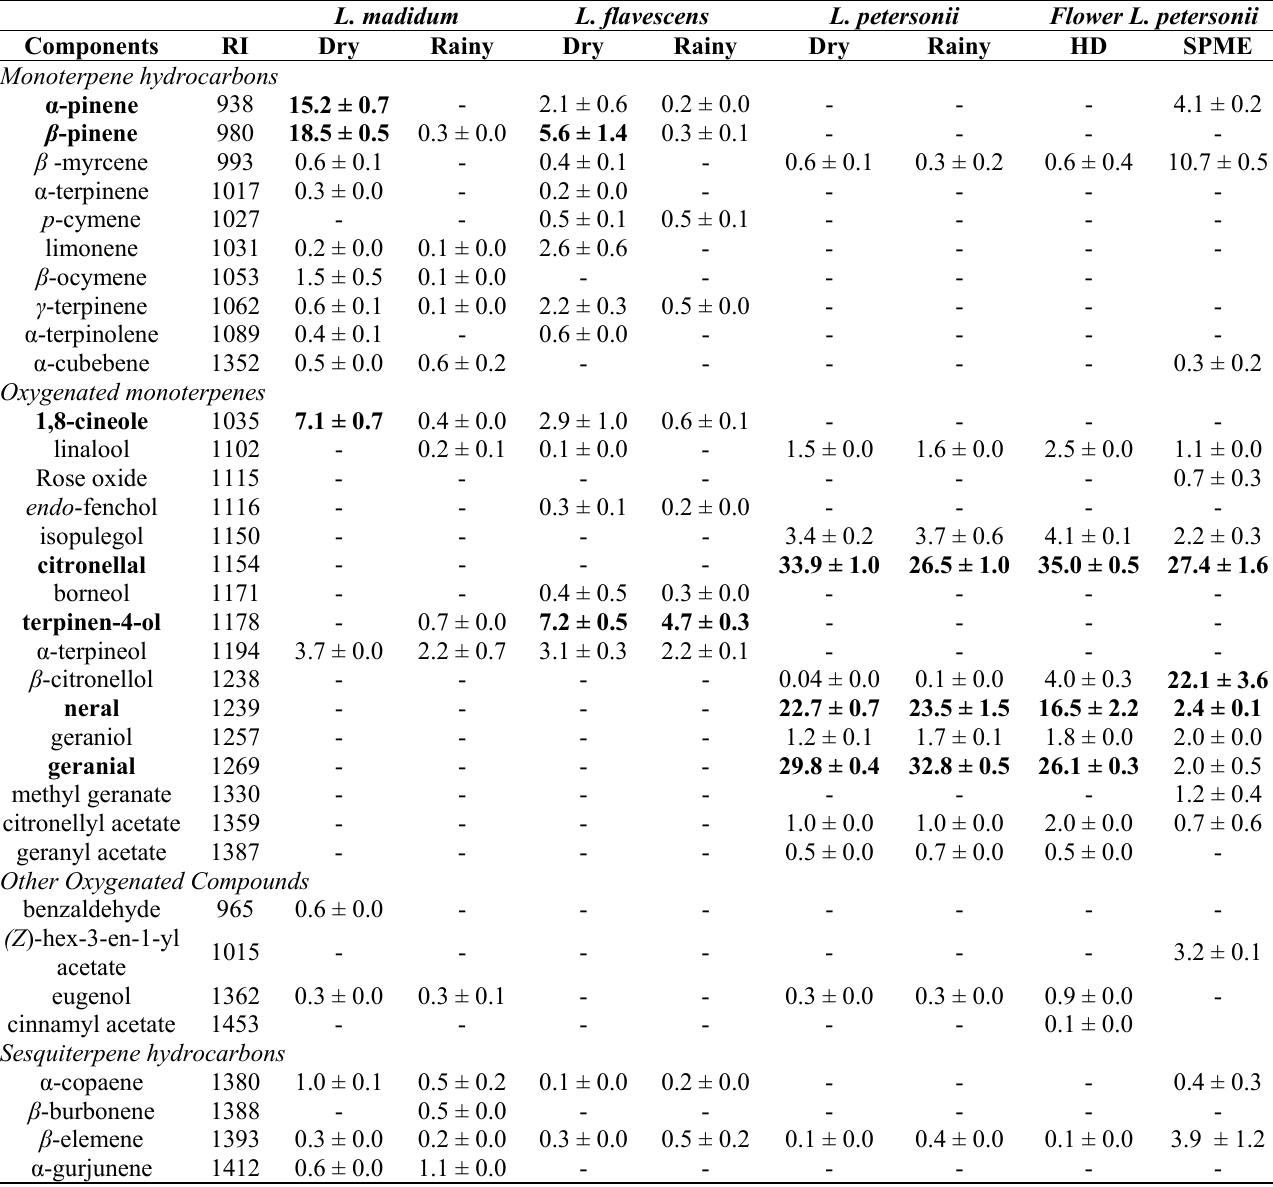
Table 2. Chemical composition (%) of volatile oils from Leptospermum